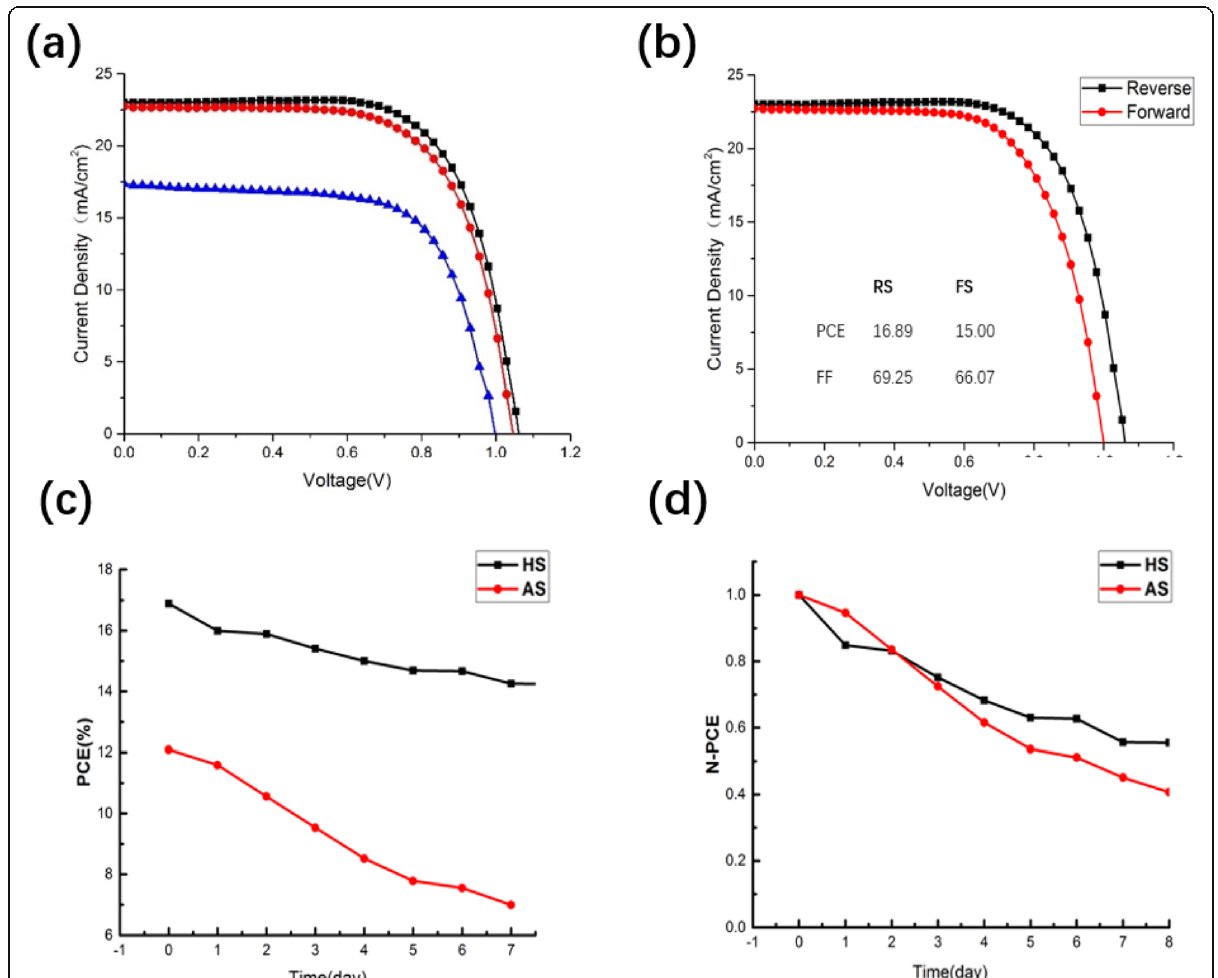
Fig. 2 a J-V cures of PSCs based on different perovskite (black line: HS EA, red line: HS DE, blue line: AS EA) (HS EA stands for PSCs based on perovskite prepared via preheating method with an anti-solvent of ethyl acetate, HS DE stands for PSCs based on perovskite prepared via preheating method with an anti-solvent of diethyl ether, AS EA stands for PSCs based on perovskite prepared via conventional method with an anti-solvent of ethyl acetate), b J-V curves of PSCs based on HS EA under different scanning direction, c PCE variation with time, and d normalized PCE variation with time